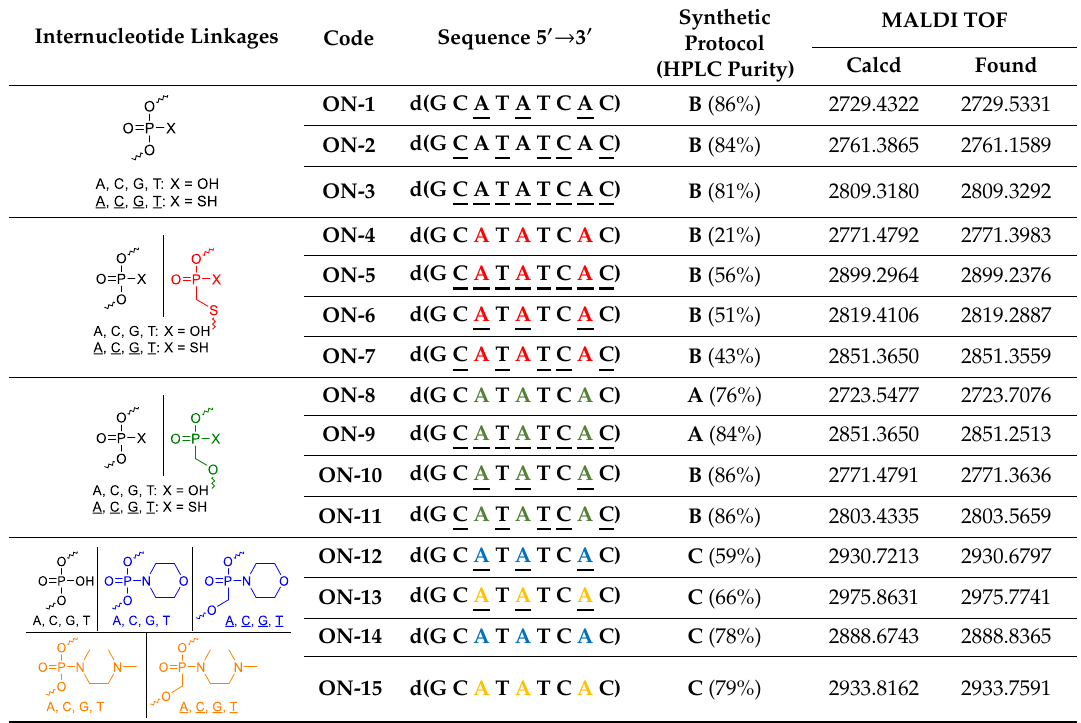
Table 3. Summary of hetero-oligonucleotides ON-1 – ON-15 . Table 3 . Summary of hetero-oligonucleotides ON-1 – ON-15 . Table 3 . Summary of hetero-oligonucleotides ON-1 – ON-15 . Table 3 . Summary of hetero-oligonucleotides ON-1 – ON-15 . Table 3 . Summary of hetero-oligonucleotides ON-1 – ON-15